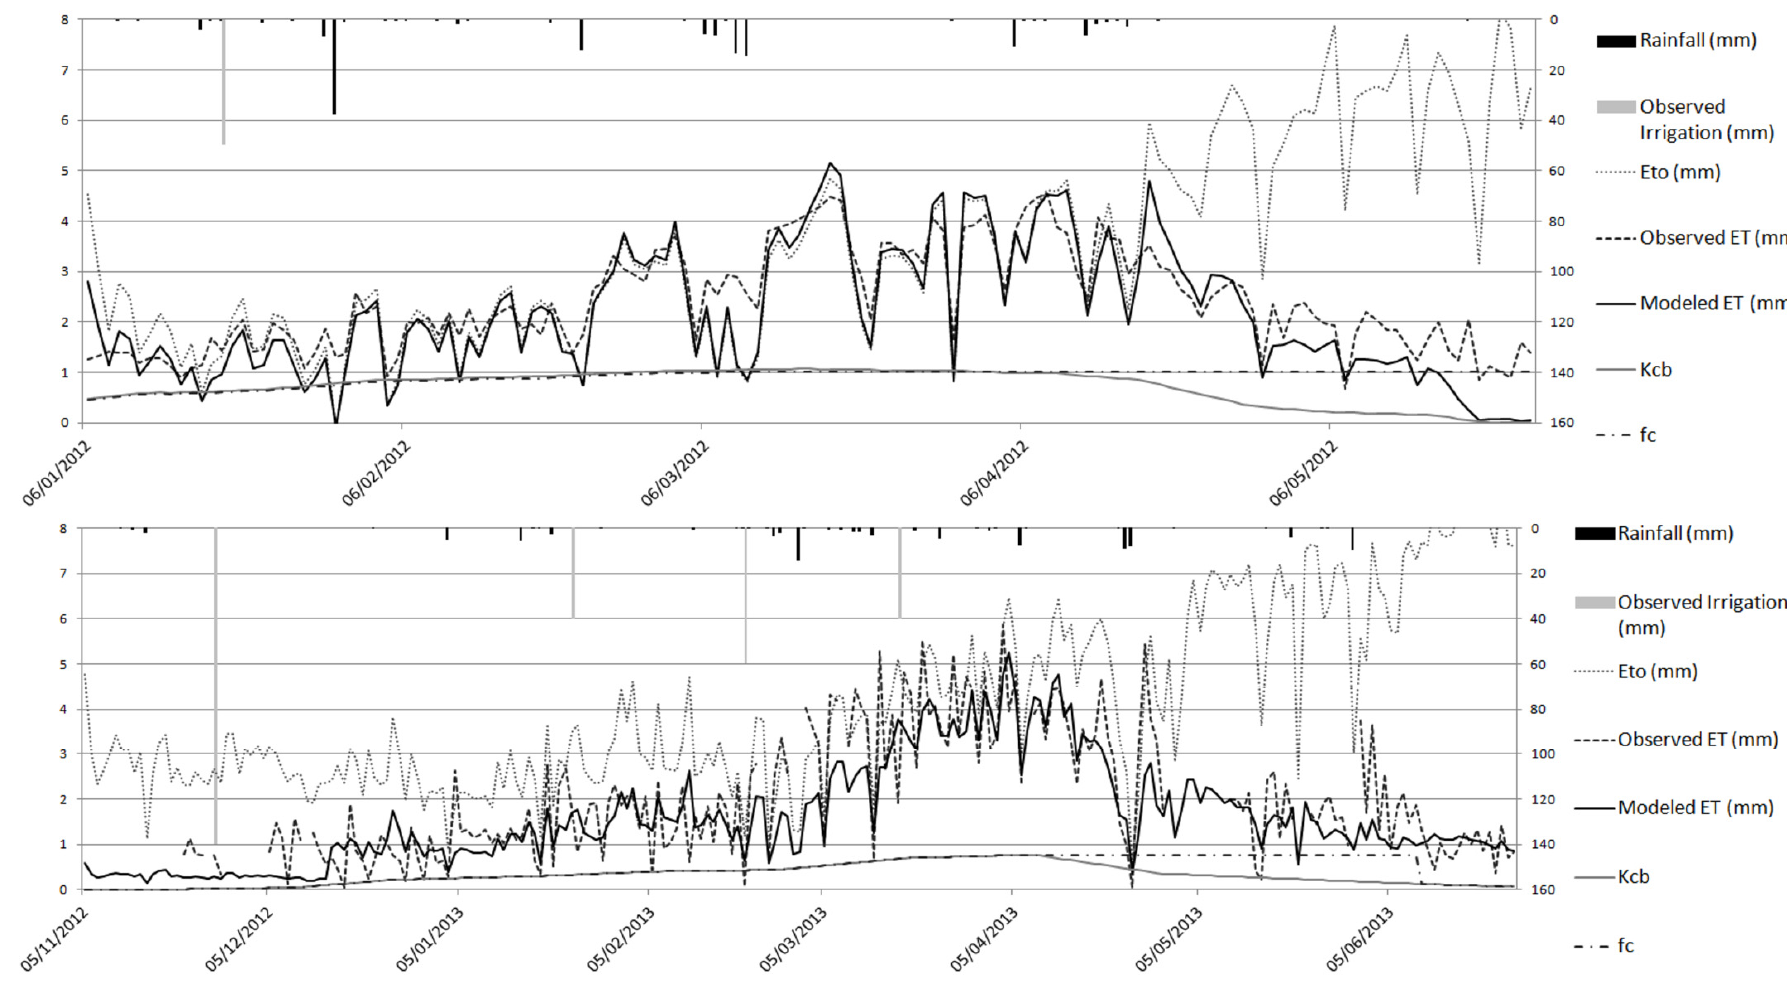
Figure 6. Simulations of ET for the ( a ) barley and ( b ) winter wheat experiment fields for the calibrated model using observed irrigations (Nash = 0.6 and 0.53,